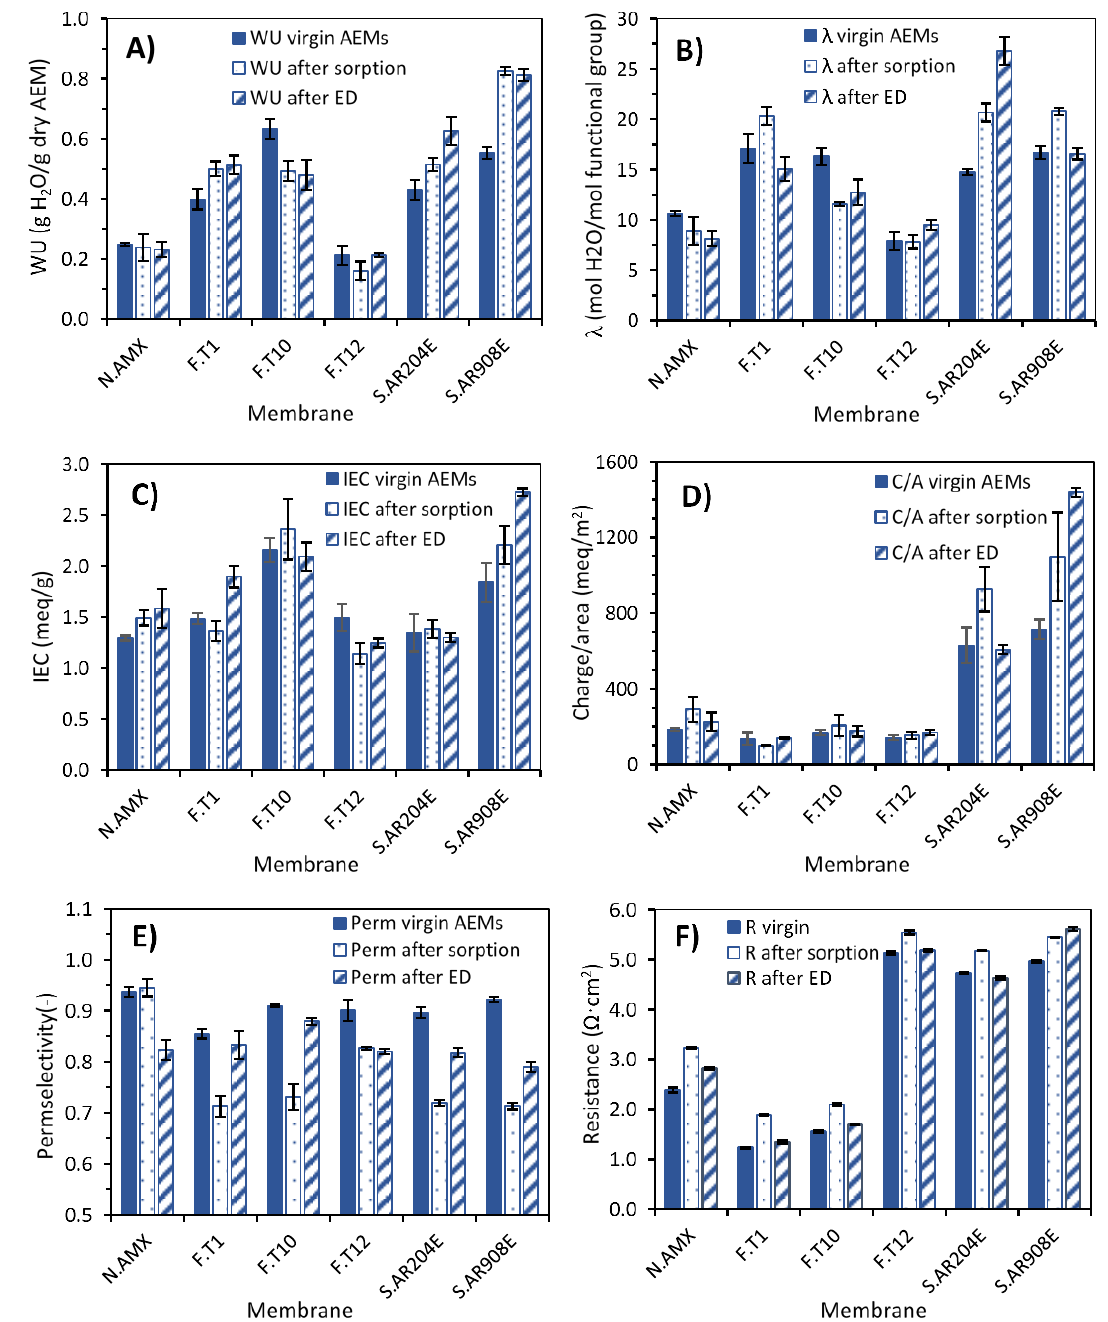
Figure 6. Comparison of membrane properties for virgin, soaked, and membranes fouled after ED. ( A ) Water uptake (WU), ( B ) hydration number (λ), ( C ) ion exchange capacity (IEC), ( D ) charge per area, ( E ) permselectivity, and ( F ) area resistance (in 0.5 M NaCl).